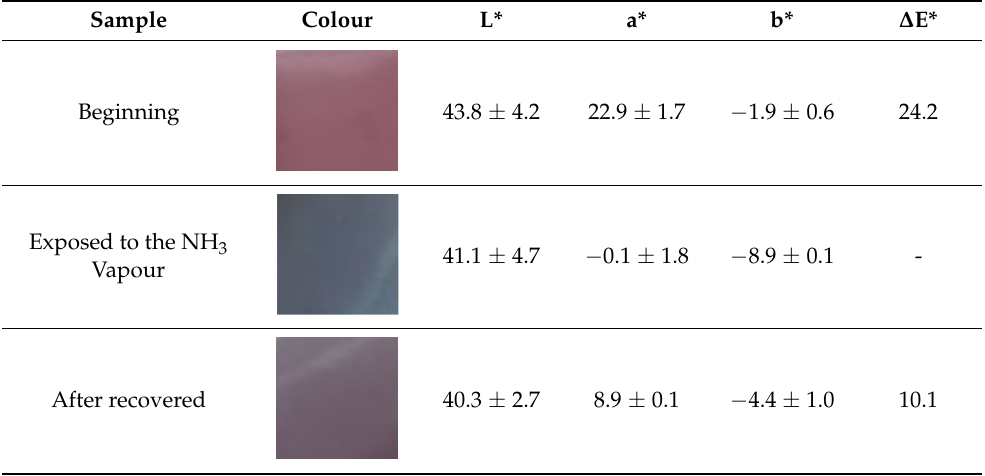
Table 1. CIELab Colour Coordinates and Total Colour Differences of BCE/PU Nanofibrous Mats.